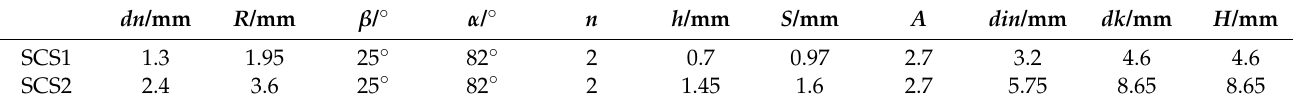
Figure 3. Schematic of the screw conveyor swirl injector.